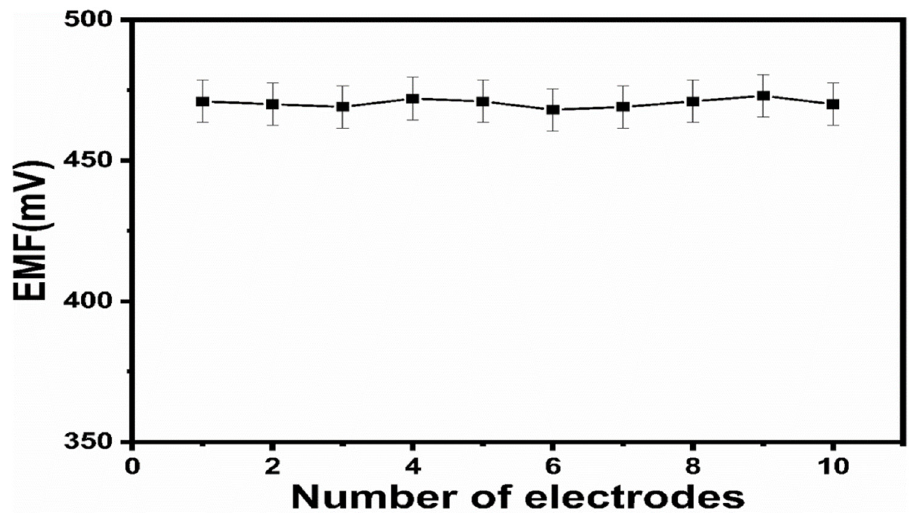
Figure 6. Inter-electrode study of cholesterol oxidase-immobilized Co 3 O 4 nanocrystals in 10 mM phosphate buffer solution of pH 7.3 in 0.5 mM cholesterol concentration.